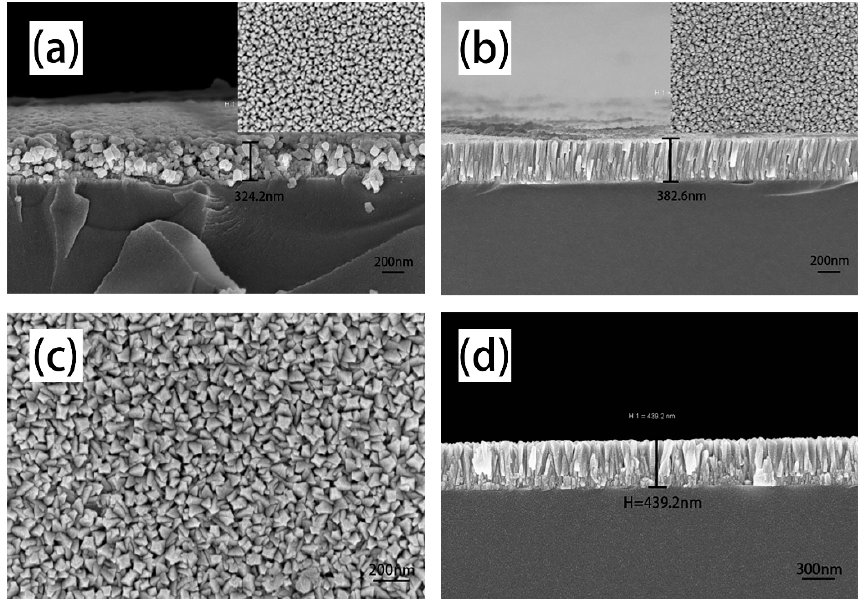
Figure 3. ( a , b ) Surface and cross-section morphology images of monolayer granular crystalline and monolayer nanopillar crystalline ITO thin film by scanning electron microscope (SEM); ( c , d ) Surface and cross-section SEM images of multiple structure nanopillar crystalline film deposited at 100 W.